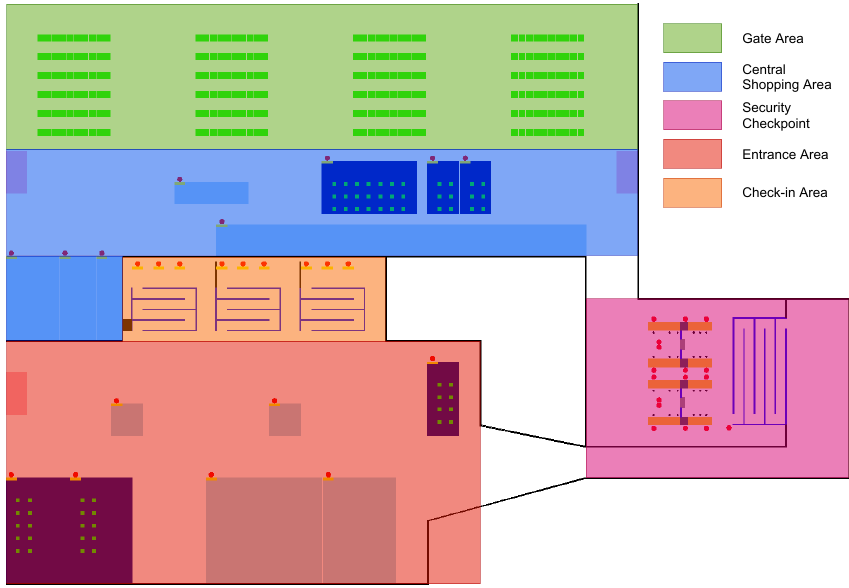
Figure 4. The environment of the agent-based